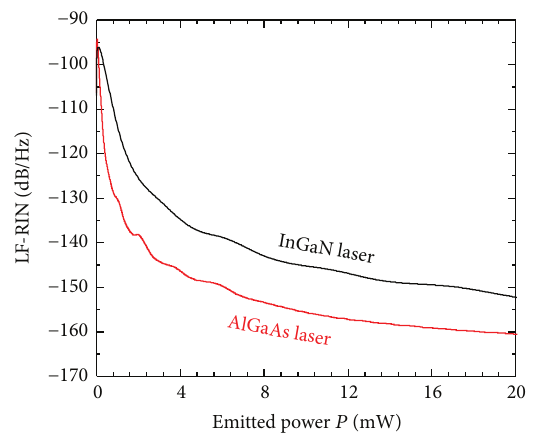
Figure 4: Variation of LF-RIN as a function of the emitted power 𝑃 .